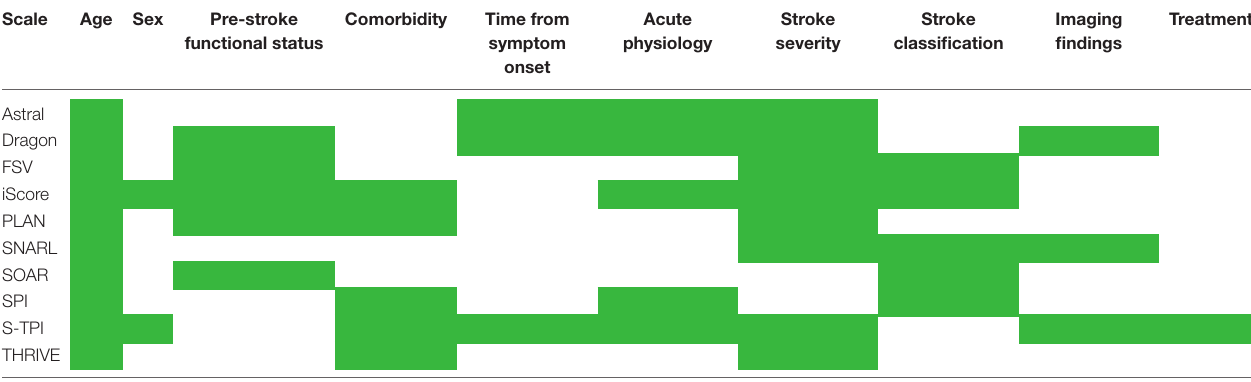
TABLE 3 | Categories of input variables included in post-stroke prognostic scales.